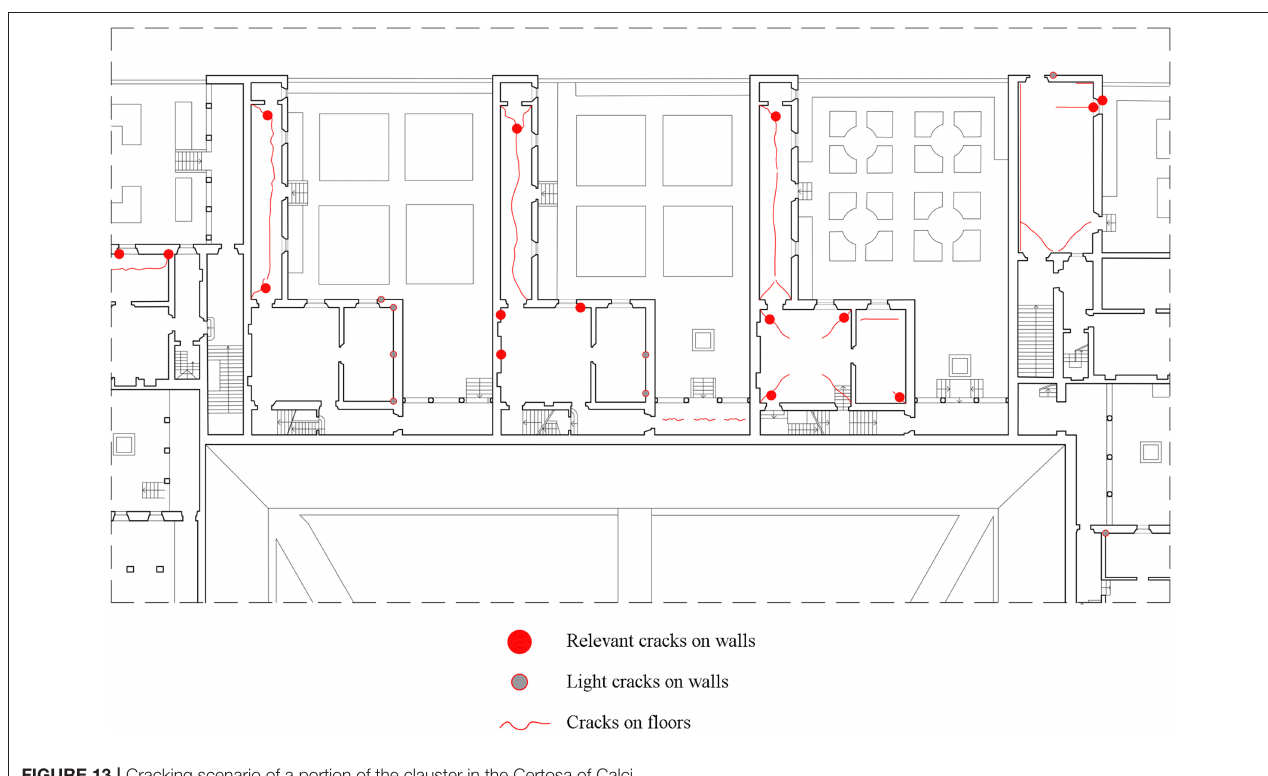
FIGURE 13 | Cracking scenario of a portion of the clauster in the Certosa of Calci.